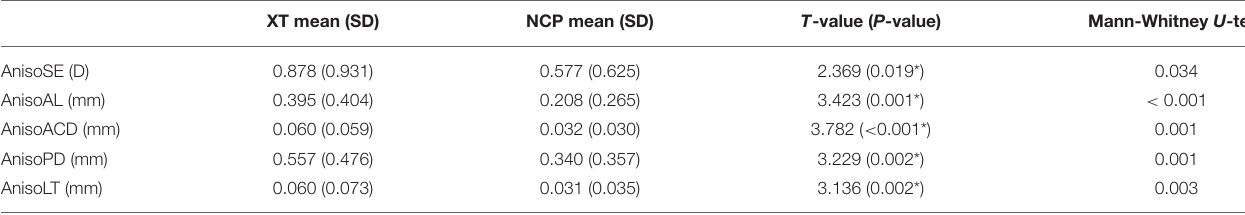
TABLE 1 | Comparisons of the absolute values of inter-eye differences between concomitant exotropia and control participants. XT mean (SD) NCP mean (SD) T -value ( P -value)